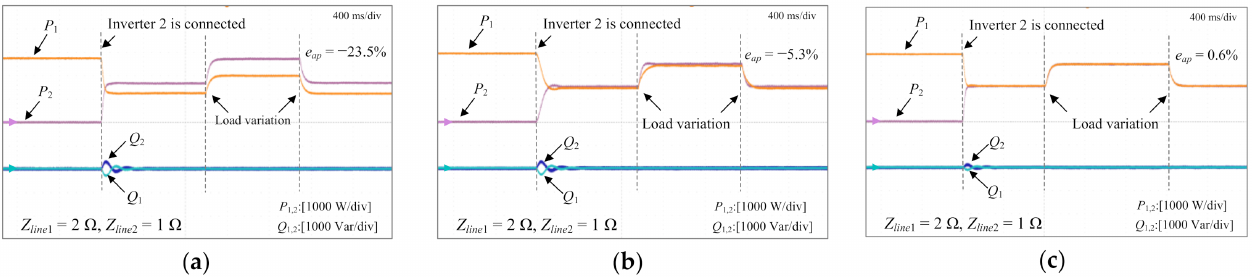
Figure 15. Experimental results of power responses with line impedance ratio of 2:1: ( a ) power sharing performance via conventional P-U/Q-f droop control method; ( b ) power sharing performance via PI-based P-U/Q-f droop control method;